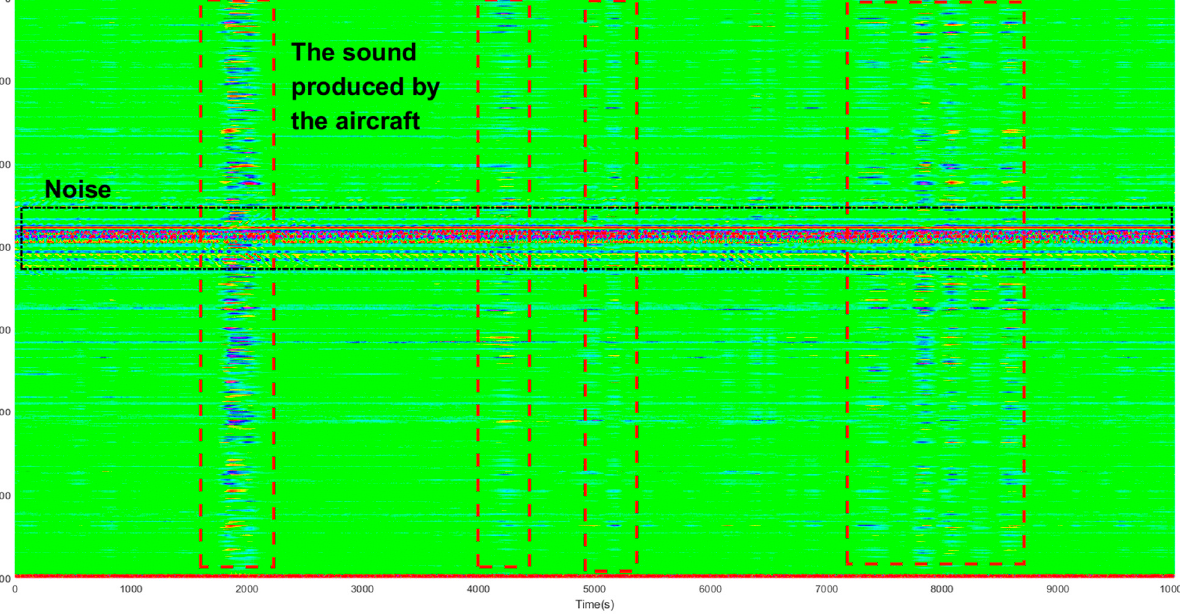
Figure 5. Original signal of an airplane.